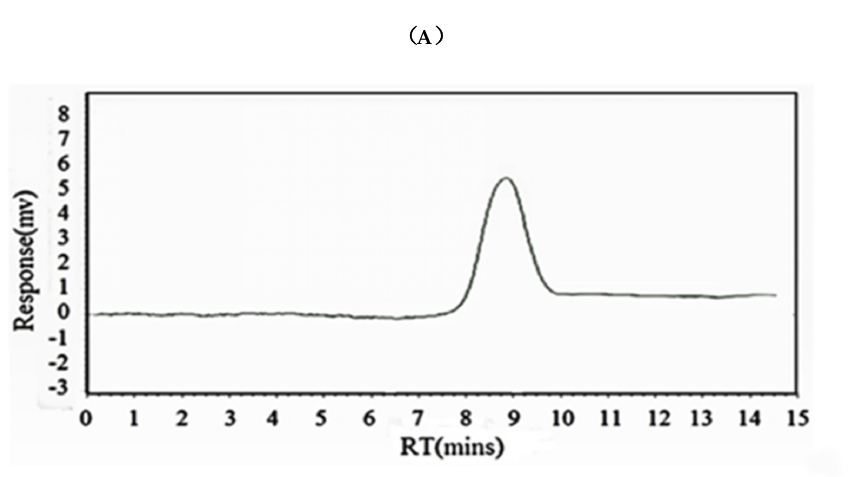
Figure 2. ( A ) The GPC gel chromatography spectrum of HIOP1-S; ( B ) The GPC gel chromatography spectrum of